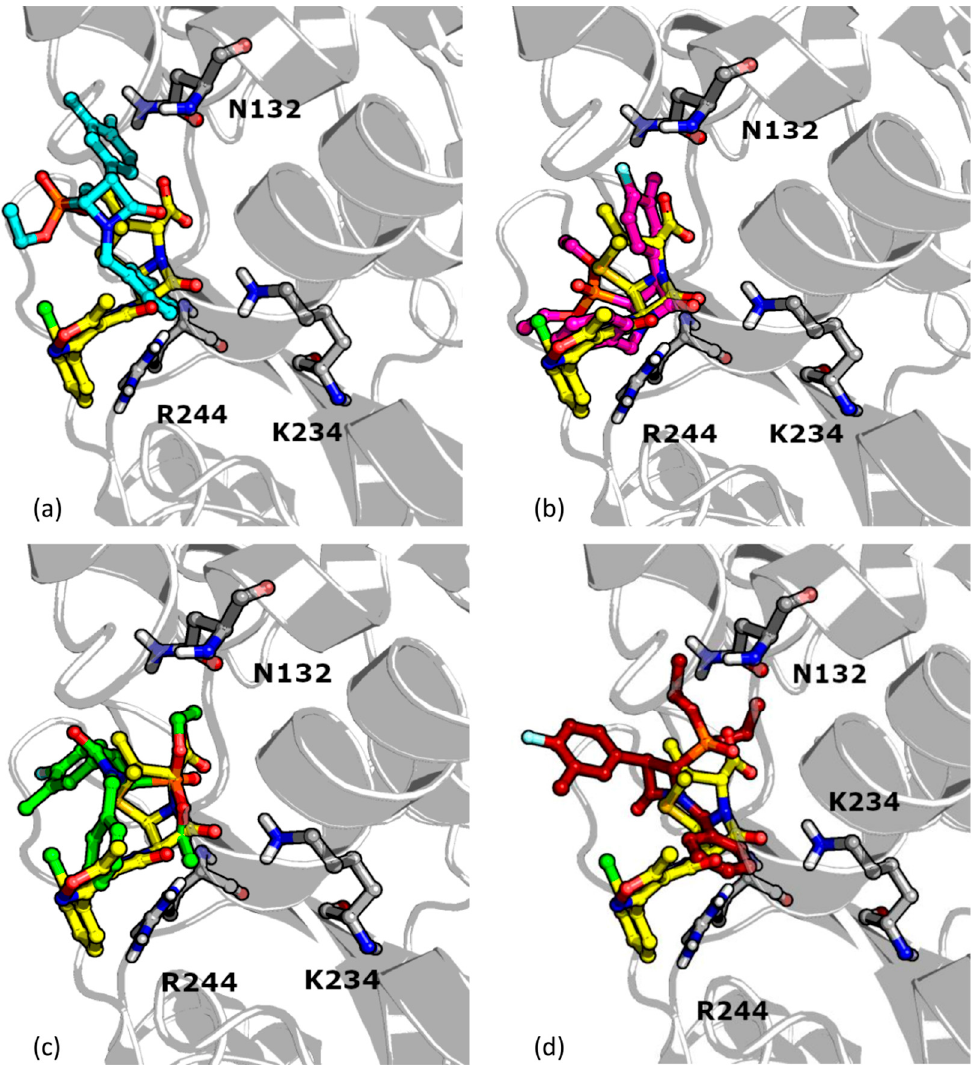
Figure 5. Docking results of compound 11f and oxacillin to β -lactamase crystal structure: ( a ) (3 R ,4 R )- 11f , ( b ) (3 S ,4 S )- 11f , ( c ) (3 S ,4 R )- 11f , ( d ) (3 R ,4 S )- 11f ; oxacillin is always depicted in yellow.